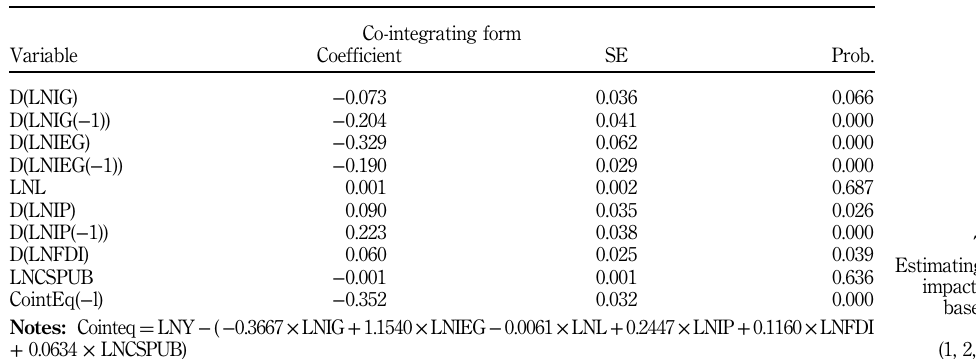
Table VII. Estimating long-term